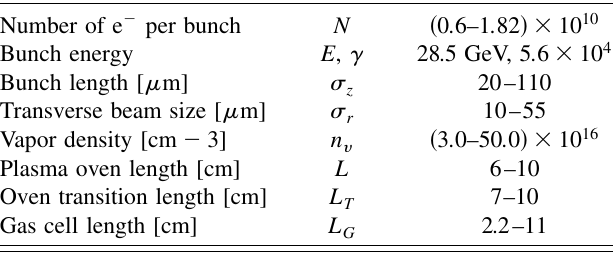
Data run experimental conditions. Typical beam and plasma